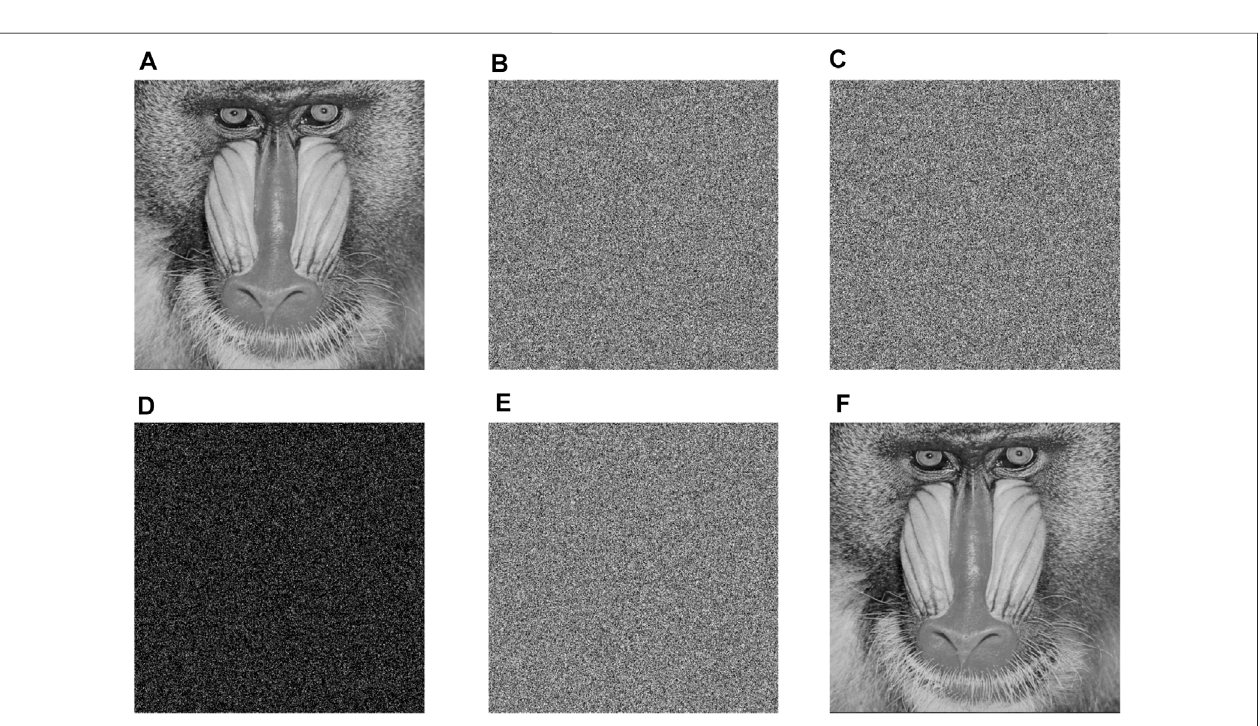
FIGURE 10 | Key sensitivity analysis result graph, including (A) original Lena graph, (B) ciphertext encrypted with key 1, (C) ciphertext encrypted with key 2, (D) difference graph of two ciphertexts, (E) result graph of decryption with wrong key, and (F) result graph of decryption with correct key.